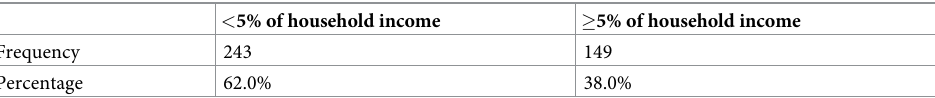
Table 4. Respondents’ ability to pay for the annual CBHI premium using expenditure to the income